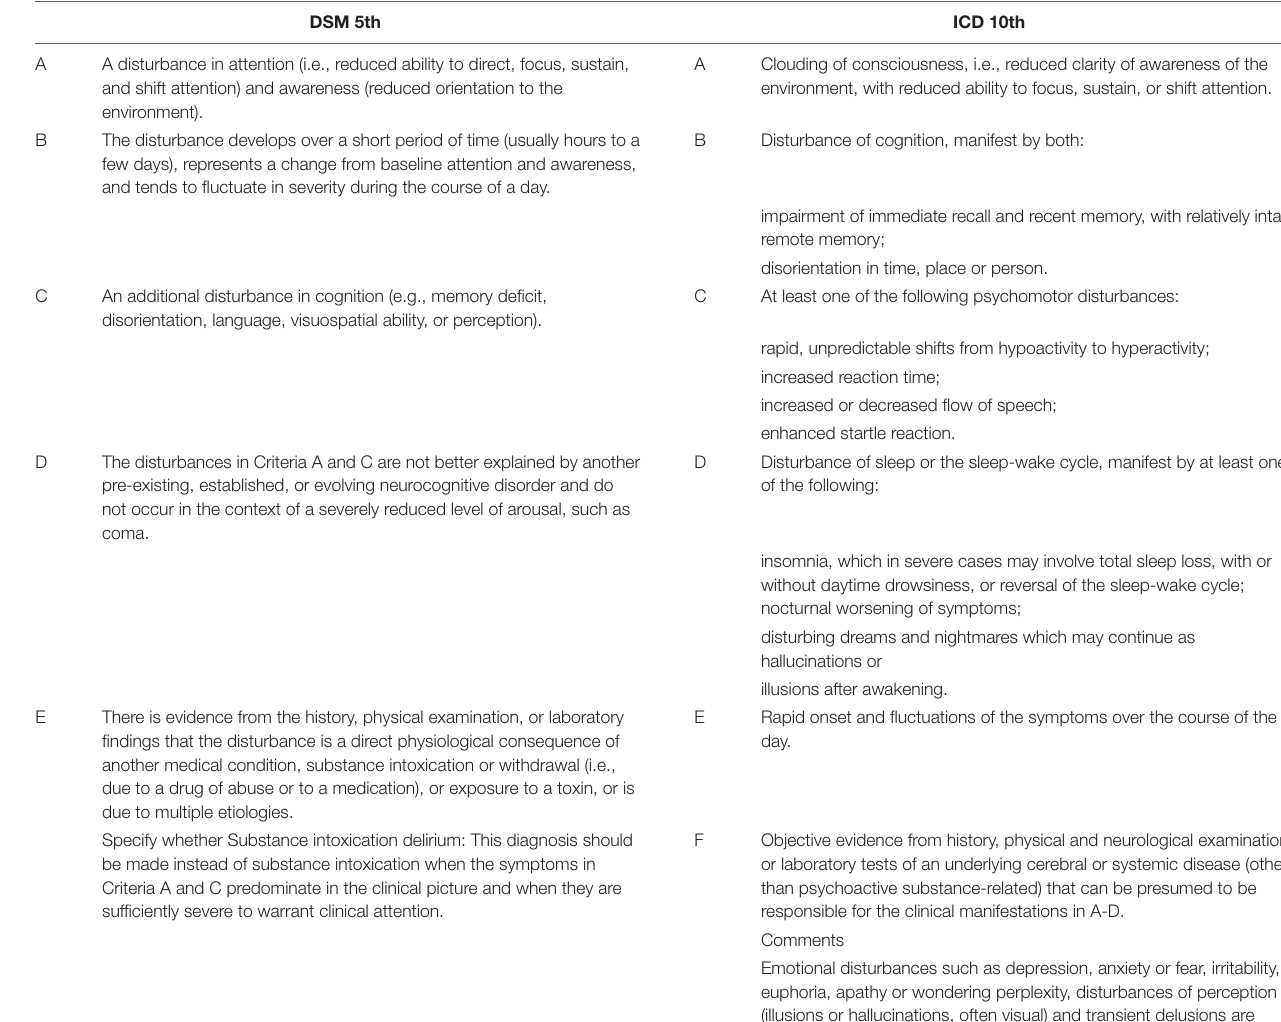
TABLE 1 | The criteria used to diagnose delirium: the Diagnostic and Statistical Manual of Mental Disorders (DSM) -5th edition and the International Statistical Classification of Diseases and Related Health Problems (ICD), 10th revision